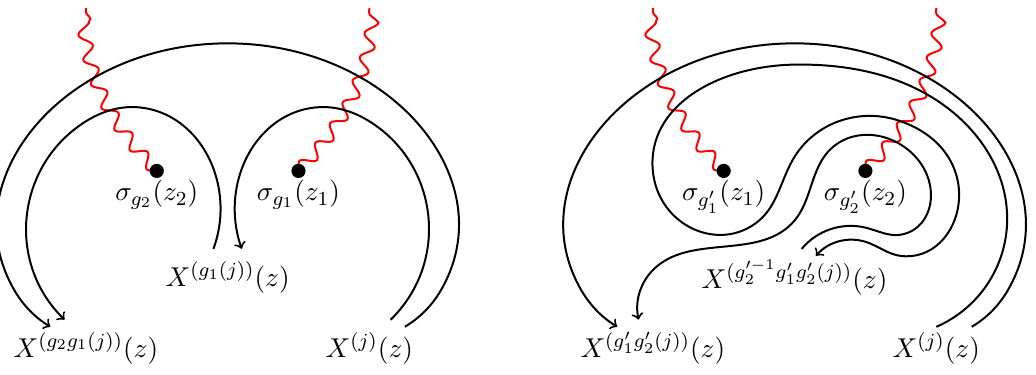
Figure 1 . Monodromy of the twist (cid:12)elds. We drew our choice of branch cuts as red wiggly lines. Every time the contour crosses the branch cut (the symmetry defect), the (cid:12)eld picks up the mondromy of the twist